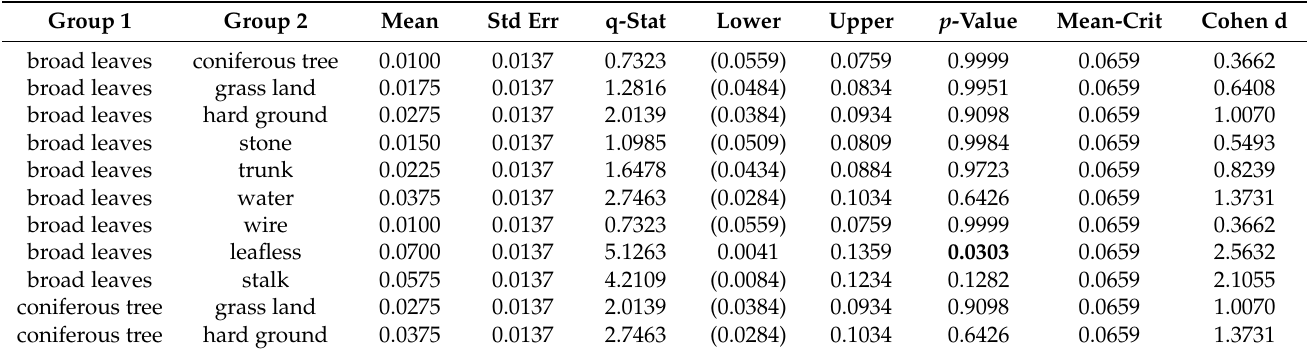
Table A3. Tukey’s HSD Post Hoc Test results regarding the F1-score of various